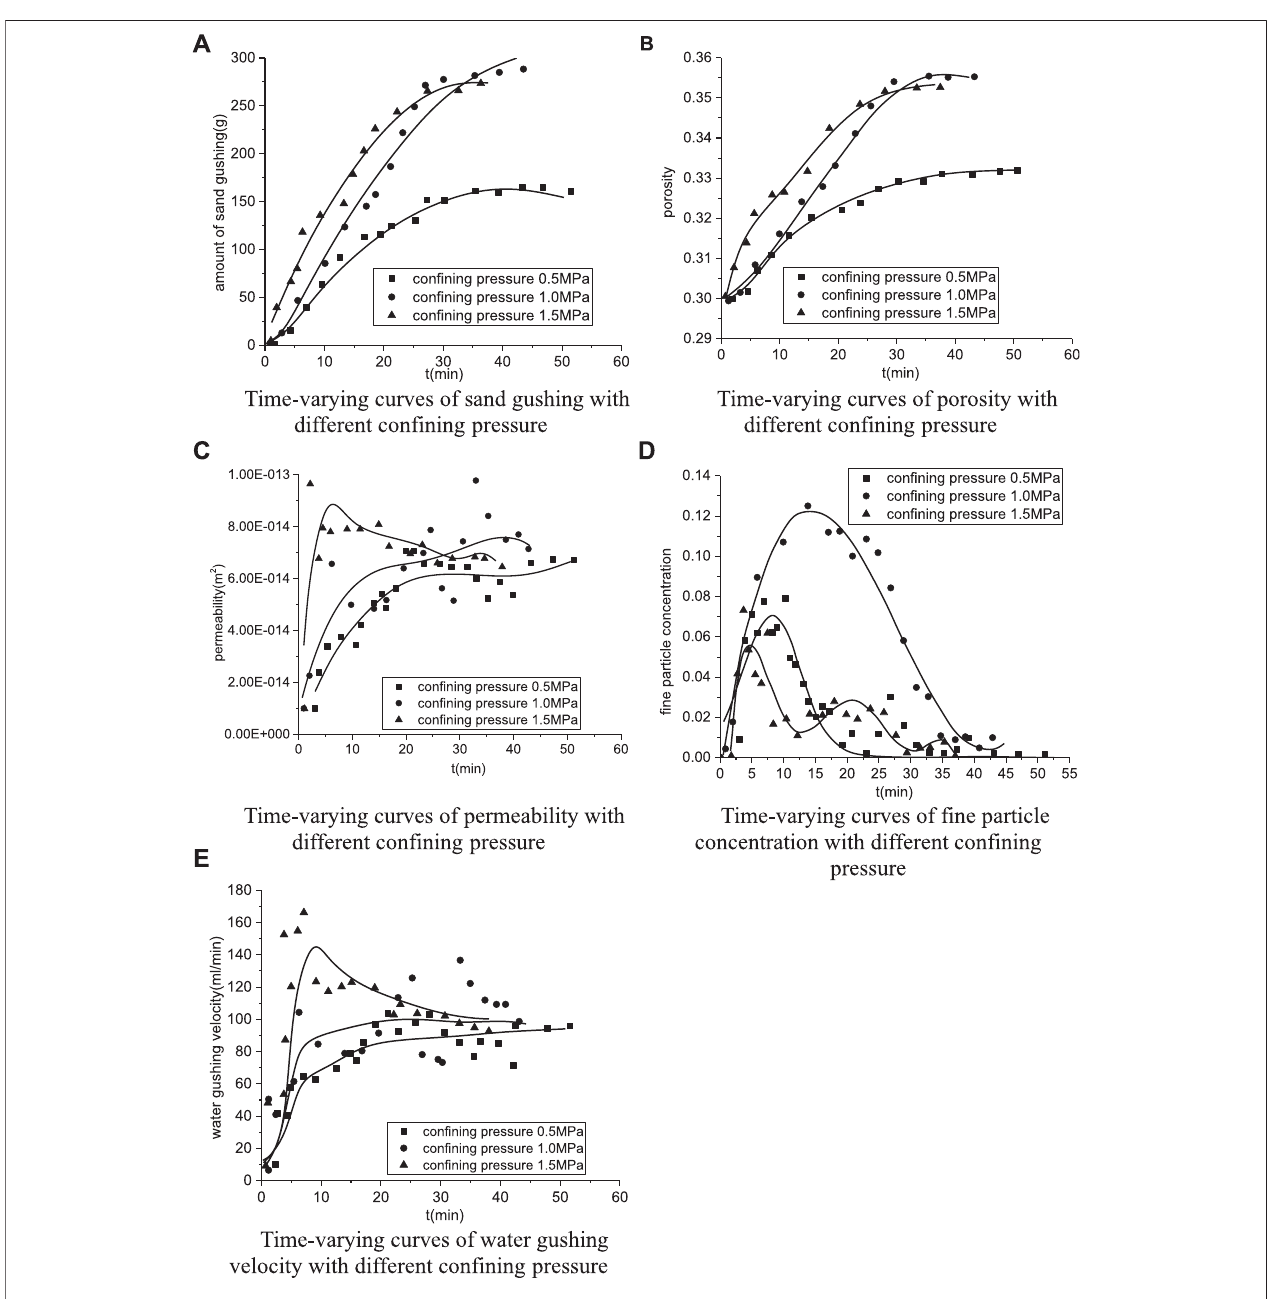
FIGURE 12 | In fl uence of con fi ning pressure on the evolution of water bursting and sand gushing: (A) time-varying curves of sand gushing with different con fi ning pressures, (B) time-varying curves of porosity with different con fi ning pressures, (C) time-varying curves of permeability with different con fi ning pressures, (D) time- varying curves of fi ne particle concentration with different con fi ning pressures, and (E) time-varying curves of water gushing velocity with different con fi ning pressure.